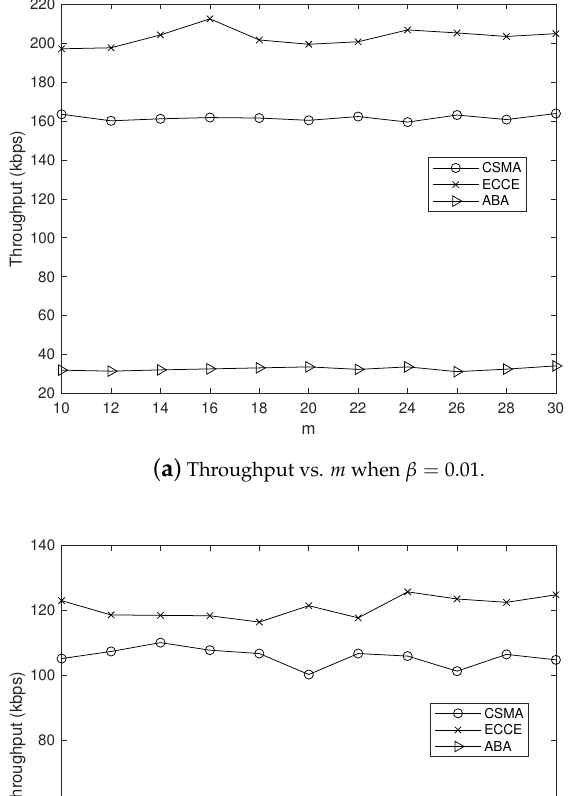
( b ) Throughput vs. m when β = 0.02.